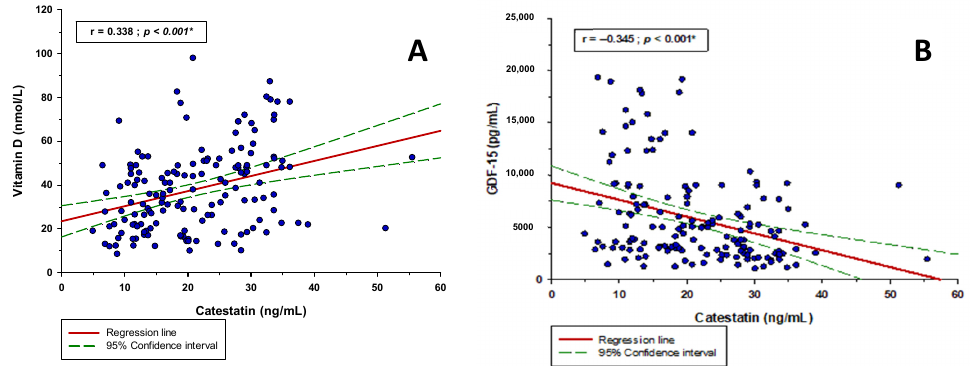
Figure 2. Comparison of the ( A ) vitamin D and ( B ) GDF-15 levels between the fatal ( n = 47) and the non-fatal group ( n = 105). Data are presented as mean ± standard deviation. Abbreviations: GDF- 15—growth differentiation factor-15. * Student’s t -test. # Hedges’ g. There was a significant positive correlation between serum catestatin levels and vit- amin D levels (r = 0.338; p < 0.001) and significant negative correlation between serum catestatin levels and GDF-15 levels (r = − 0.345; p < 0.001) (Figure 3). Moreover, catestatin had a significant positive correlation with systolic BP (r = 0.170; p = 0.036) and diastolic BP (r = 0.201; p = 0.013) (Table 3).